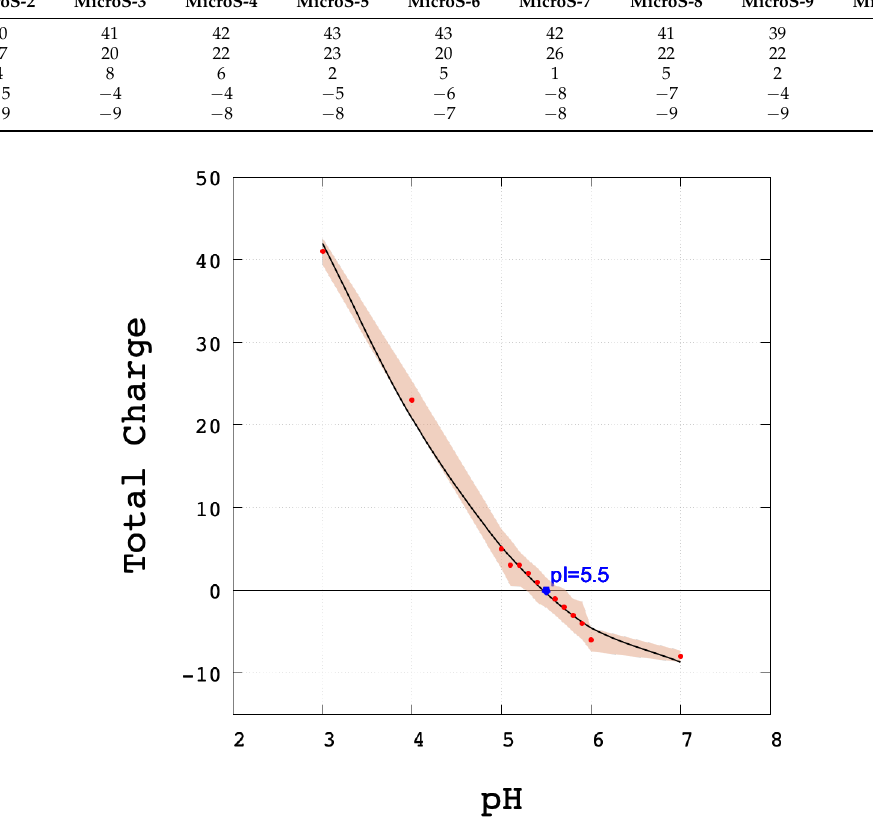
Figure 3. Total charge of Mpro at different pHs. The representation of smooth (colour) indicates the average and the error for each microstate, the estimated computationally pI = 5.5 is in blue colour, and the points were fitted to a polynomial regression line (black